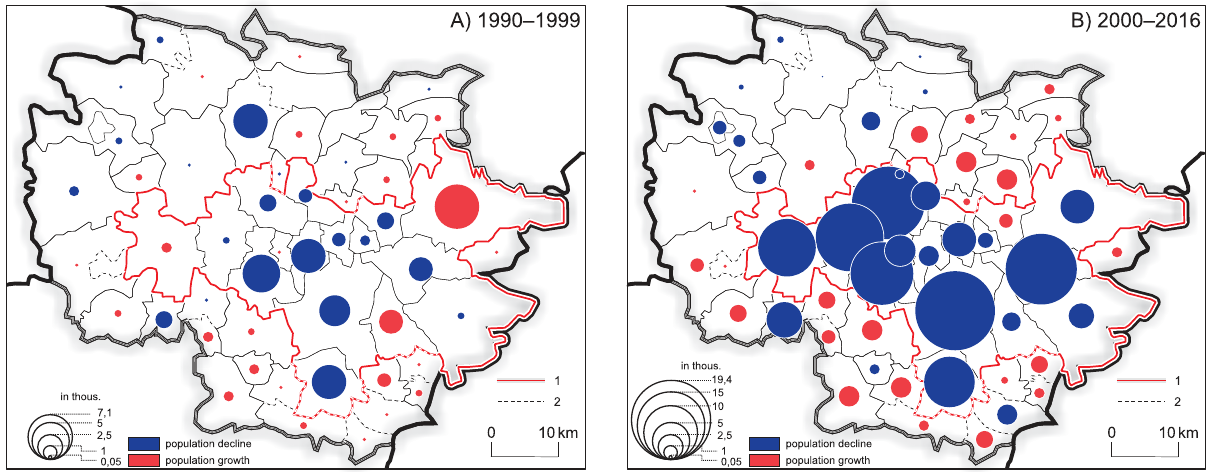
Fig. 7. Net migration for the communes of the Katowice conurbation (aggregate) in the periods A) 1990–1999 and B) 2000– 2016 (Source: own elaboration based on Local Data Bank of the Central Statistical Office; Rocznik Statystyczny Województwa Katowickiego 1981,–1995, WUS,